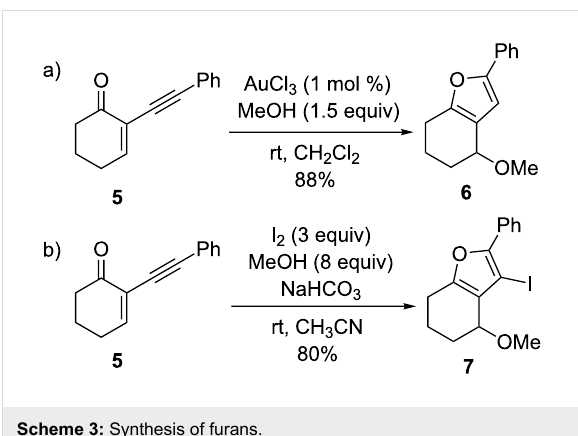
Scheme 2: Synthesis of 3(2 H